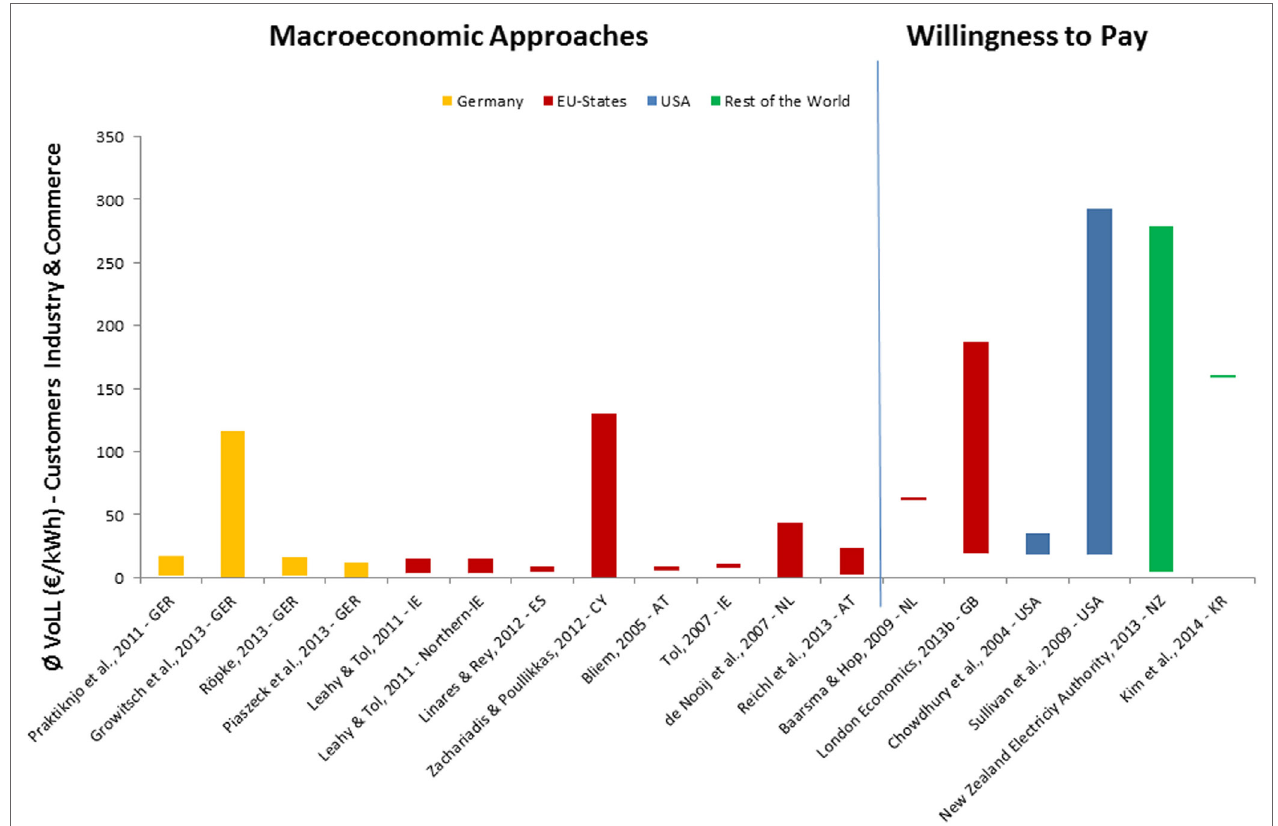
FiGURe 2 | Actual voLL studies – economic end users